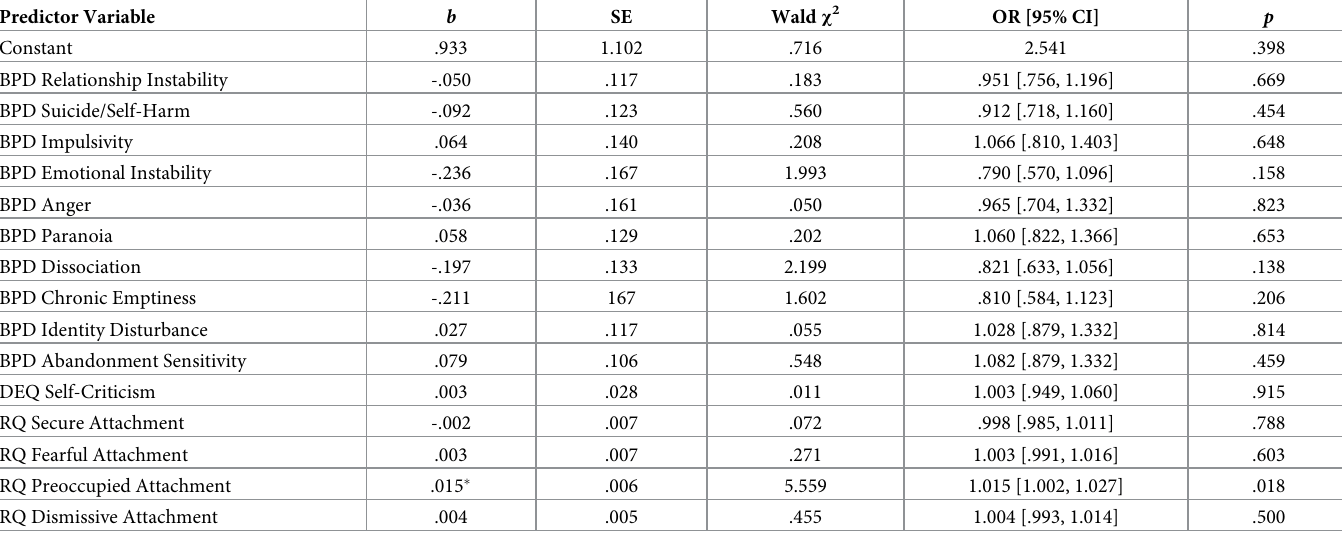
Table 5. Individual regression coefficients (b), standard errors (SE), Wald chi-square statistics (Wald χ 2 ), Odds Ratios (OR) with 95% confidence intervals [95% CI], and p values for each individual predictor for the likelihood of being categorised as a non-responder regarding psychological distress after treatment. Predictor